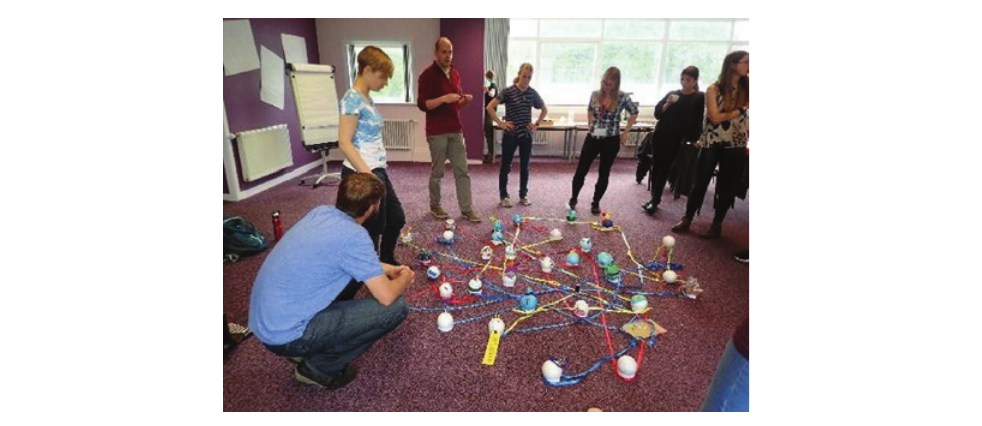
figure 4: connecting our research interests, represented by our crafted research representations, with ribbons (credit: aquarela Images)